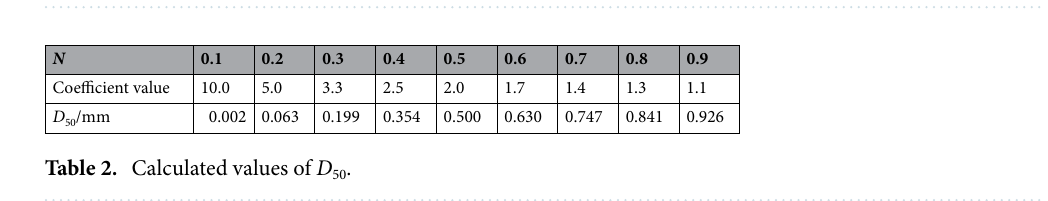
Figure 3. Characteristics of Reynolds number distribution of each group of specimens.